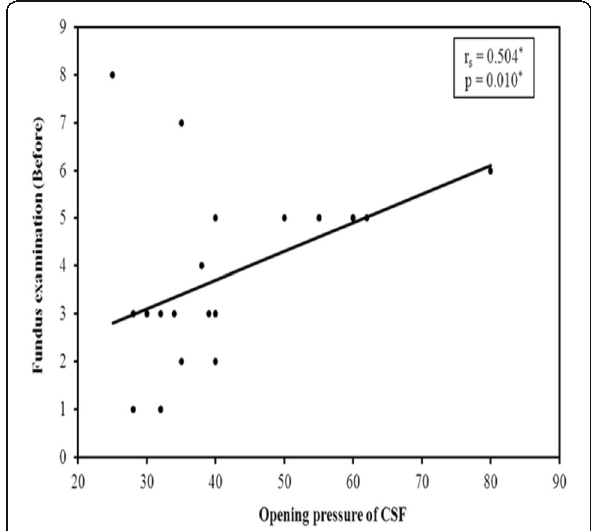
Fig. 2 Correlation between opening pressure of CSF with